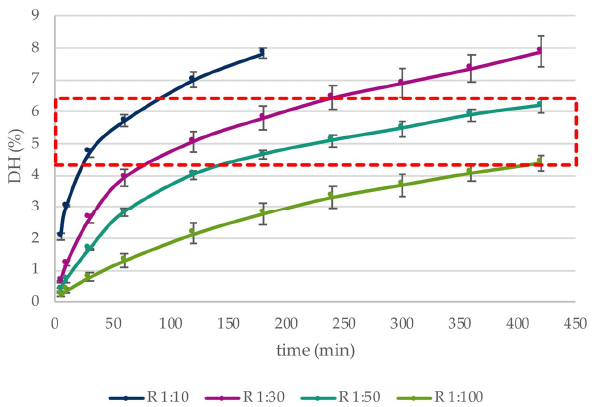
Figure 1. The effect of a targeted hydrolysis protocol (pH 8.5, 25 °C) on the % degree of hydrolysis (%DH) vs. incubation time (min) of whey protein isolate using trypsin at different enzyme:substrate ratios (E:S 1:10, 1:30, 1:50, 1:100). All trials were conducted in triplicate. Values represent mean ± standard deviation.